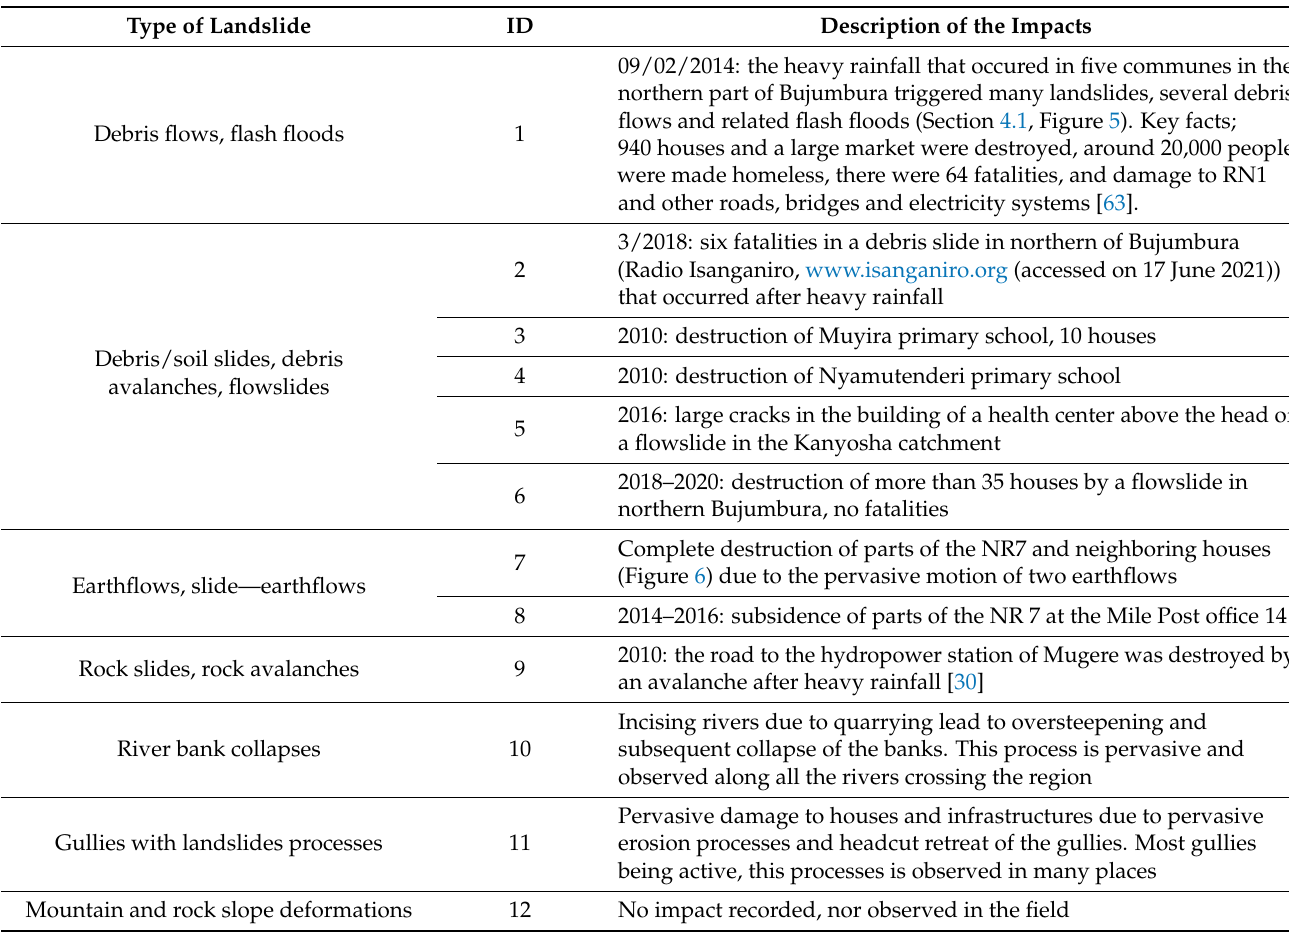
Table 3. Examples of impacts associated with landslide types. These impacts have been recorded in archive sources and/or observed directly in the field. They are located in Figure 2a with their